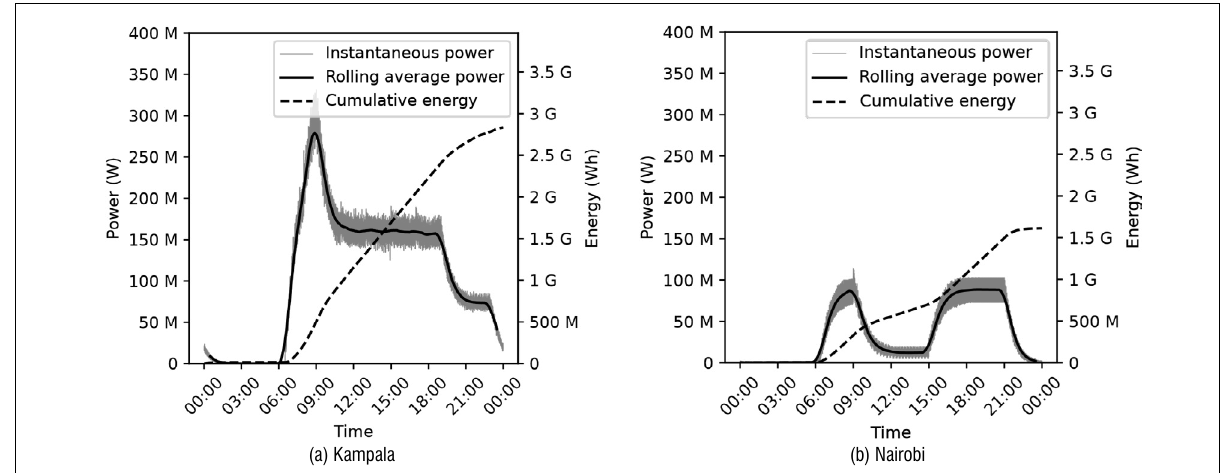
Figure 1: Daily power and energy profiles of minibus paratransit systems in Kampala and Nairobi, from passenger-based